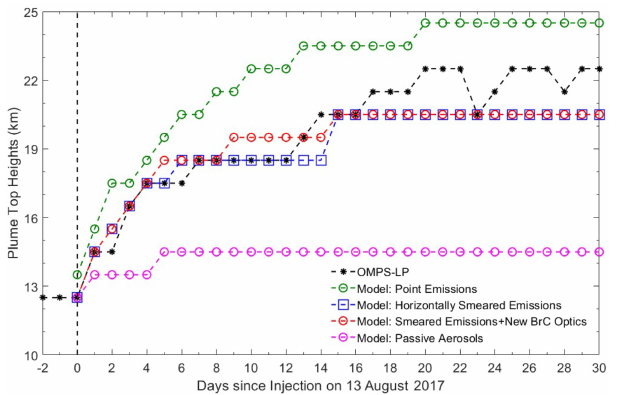
Figure 4. Sensitivity of plume rise to different assumptions of in- jection parameters, aerosol optical properties and aerosol–radiation coupling. OMPS-LP-derived plume top heights (km) are depicted in black, while model-simulated plume top heights are depicted in colored lines, where each color represents a different model as- sumption. Plume top heights are defined as the maximum altitude at which mean aerosol extinction (including pyroCb smoke) exceeds the mean background aerosol extinction. The mean aerosol extinc- tion and mean background aerosol extinction were calculated by averaging the zonal means over 30–90 ◦ N. See details of plume top height definition in Sect.